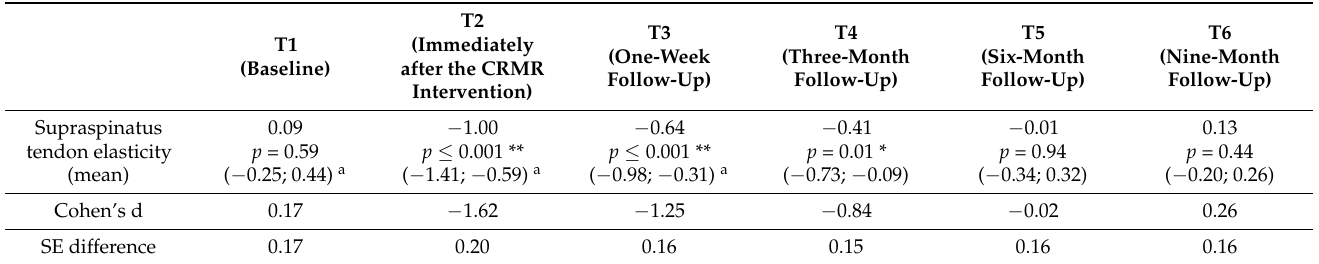
Table 2. Between group differences on supraspinatus tendon elasticity at baseline; after the interven- tion (T2); and at one-week (T3), three-month (T4), six-month (T5) and nine-month (T6) follow-ups (95%